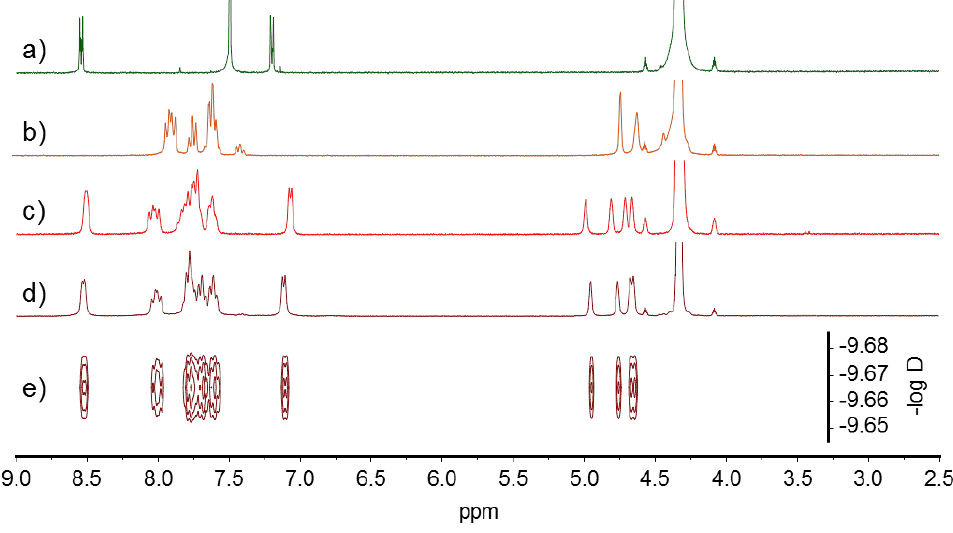
Figure 2. 1 H NMR (CD NO ): ( a ) L1 (*); ( b ) cis -Pt(dppf)(OTf) 3 2 and ( e ) DOSY NMR of 1 . (*) 1 H NMR of ligand L1 was recorded in a mixture of CD NO /CDCl 3 2 3